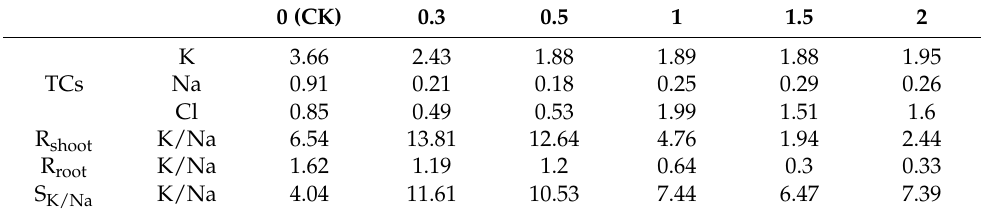
Table 2. Transfer coefficients (TCs) of K, Na and Cl, and ratios of in shoots (R shoot ) and roots (R root ), and S K/Na in plants of vetiver collected 55 d after watering with saline